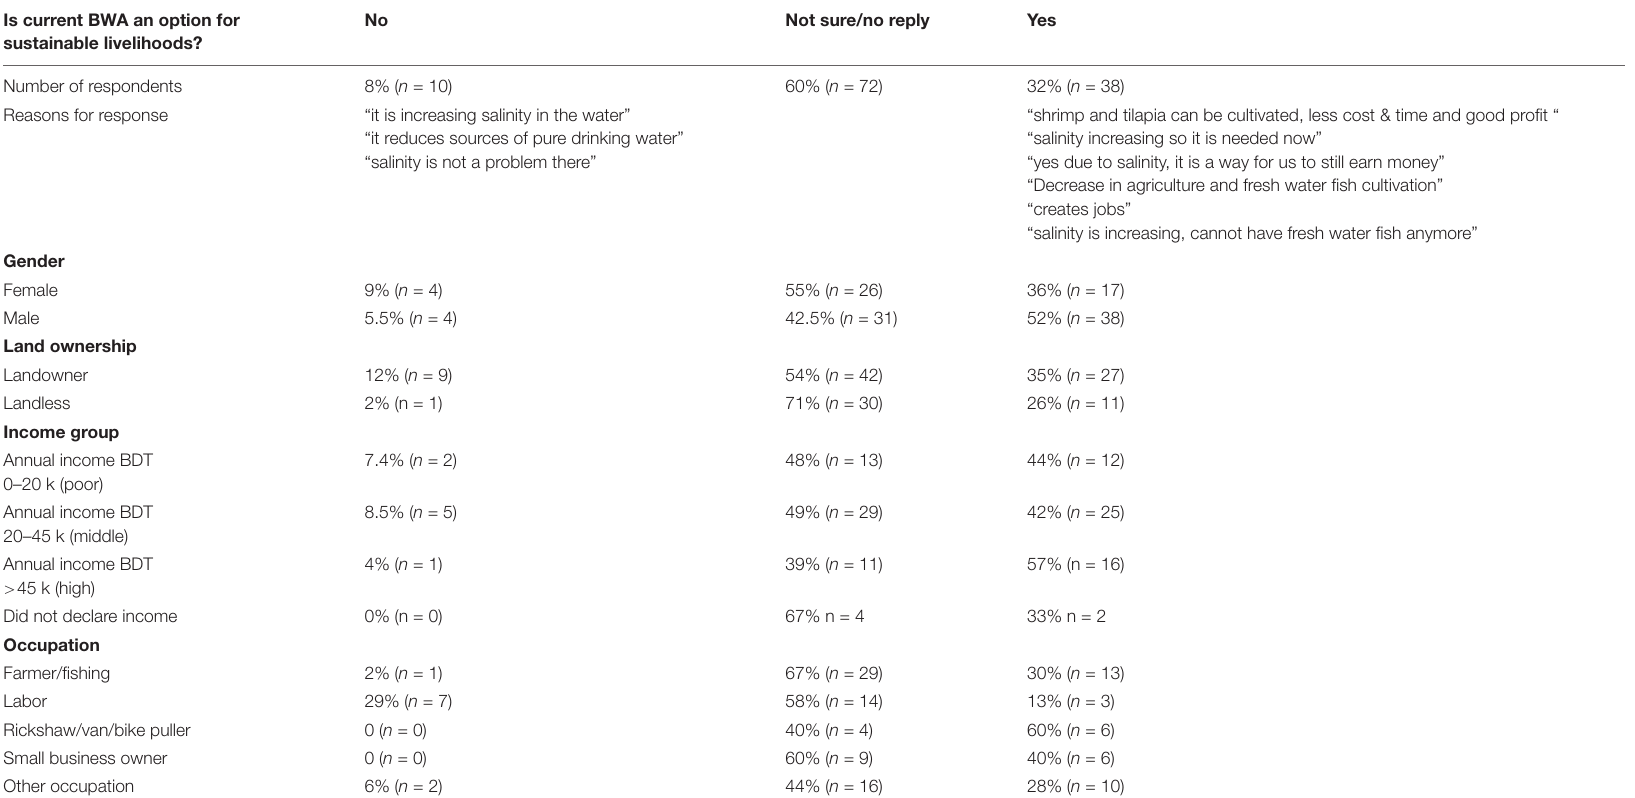
TABLE 1 | Distribution of positive attitudes toward BWA among socio-economic groups (no and % of respondents within category). Is current BWA an option for sustainable